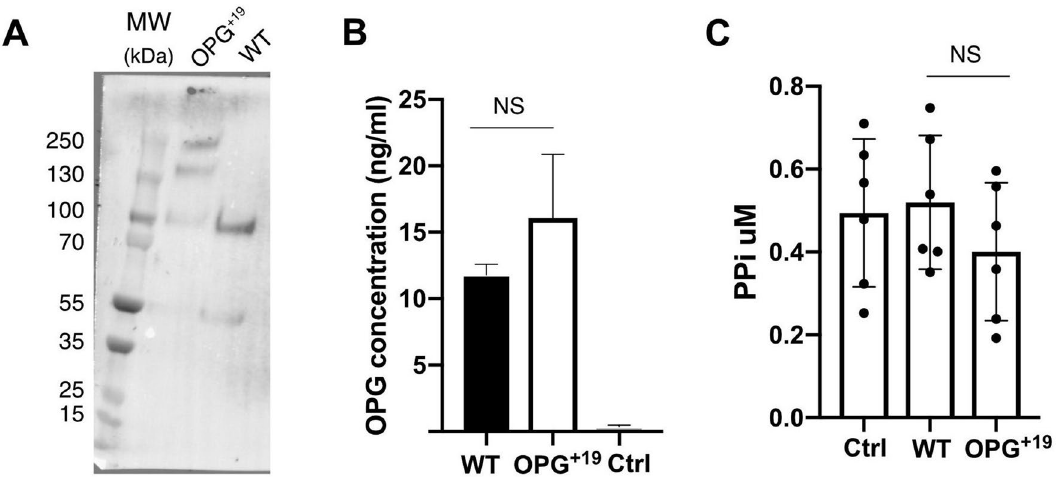
Figure 6. OPG +19 overexpressed by human chondrocytes also exists in hyper-oligomerized forms. (A-B) Expression of WT OPG and OPG mutant in a human chondrocyte cell line. Proteins were analyzed 2 days post transfection. ( A ) Culture medium were harvested and OPG purified by heparin Sepharose column. Purified WT and mutant OPG were resolved by SDS-PAGE and blotted with rabbit anti-OPG polyclonal antibody. ( B ) Concentration of secreted WT and mutant OPG in transfected chondrocyte culture medium. OPG concentration was determined by ELISA. Ctrl: medium from untransfected chondrocyte culture. n = 5. ( C ) The PPi concentration in the culture medium were determined 2-days post transfection using a commercial PPi assay kit. Ctrl: medium from untransfected chondrocyte culture. n =